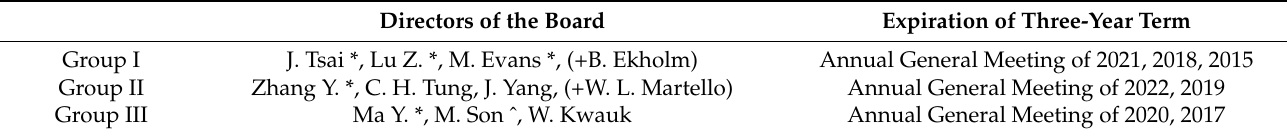
Table 3. Composition of Alibaba’s Board